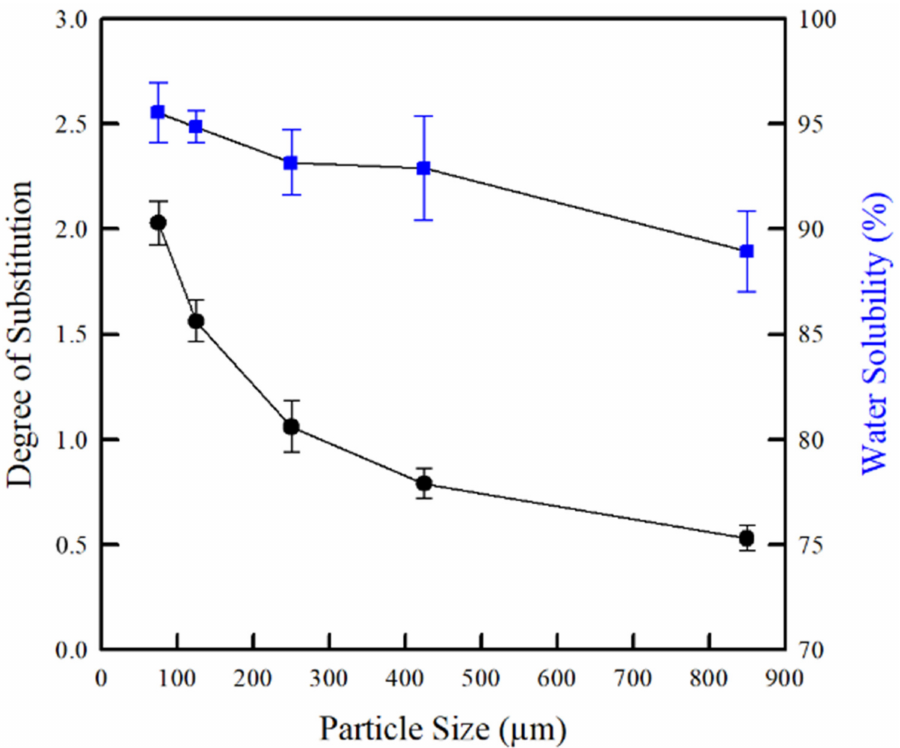
Figure 5. Effect of chitosan particle sizes on degree of substitution and water solubility of CMCh